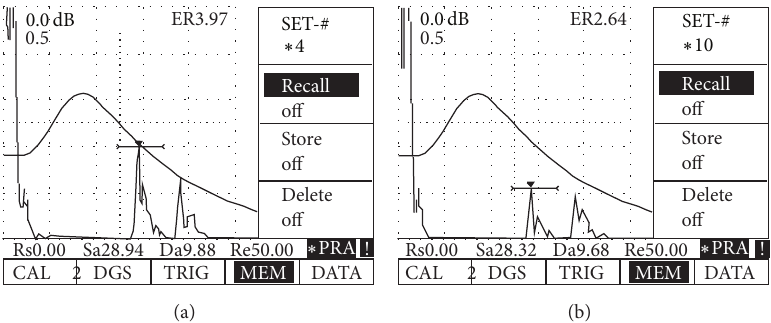
Figure 10: The ultrasonic oscillograph records of two reflectors with diameter 𝑑 = 4 mm and a backwall as a reference reflector: you can see equivalent reflector size ER = 3.97 mm for flat bottom hole (a) and side drilled hole with ER = 2.64 mm (b); DGS curve refers to Ø4mm.